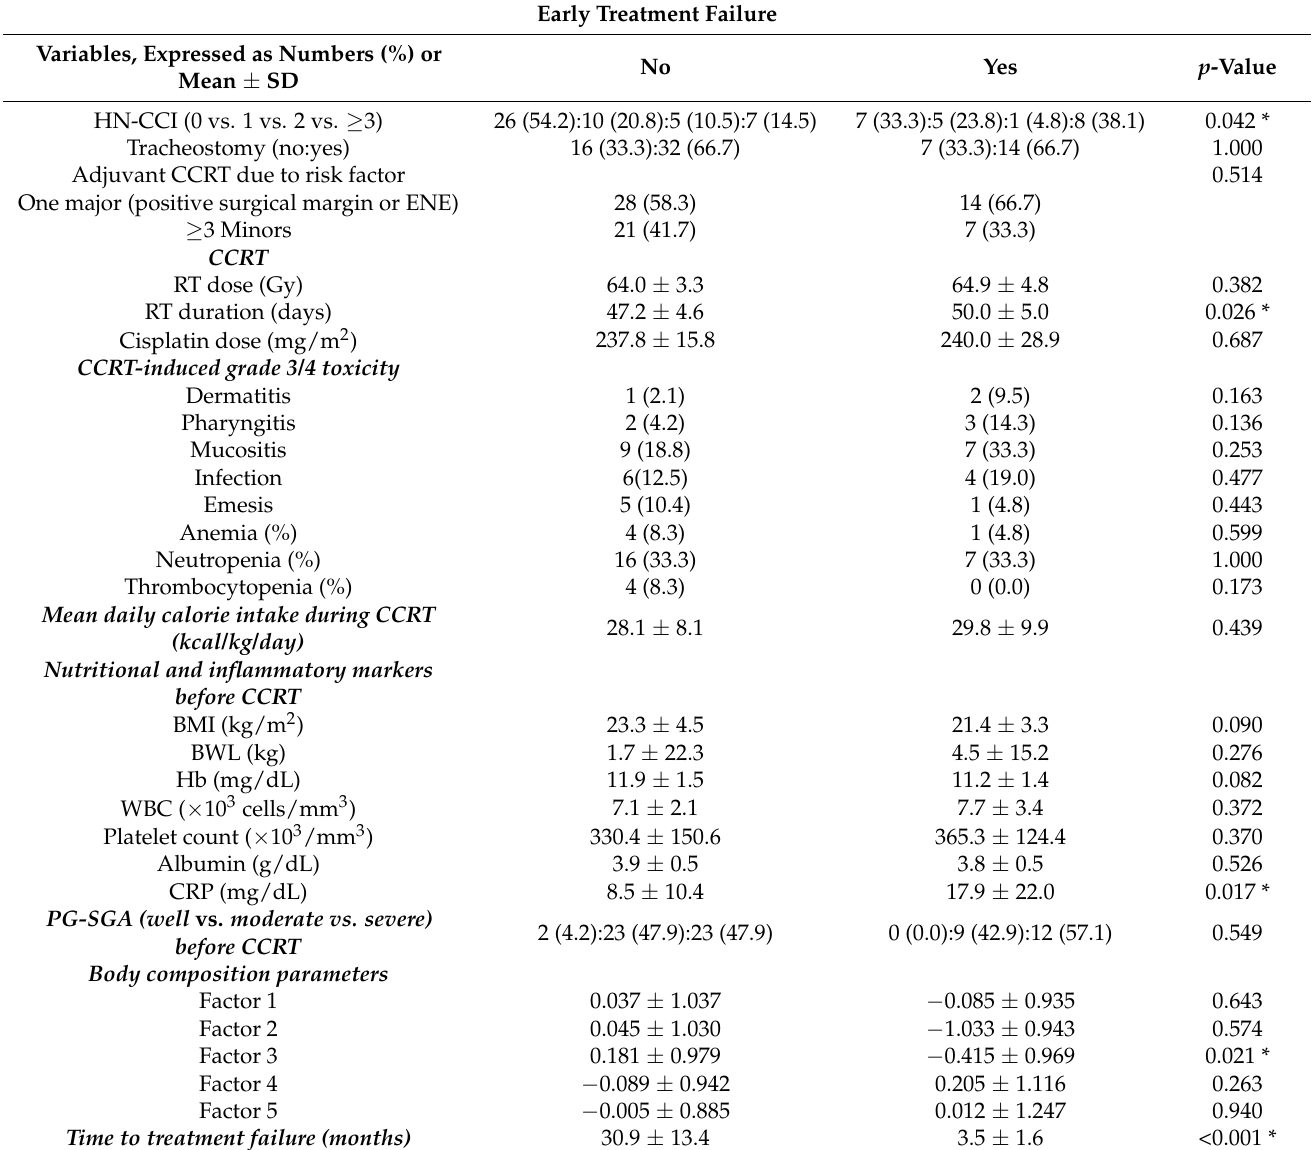
Table 3. Cont. Early Treatment